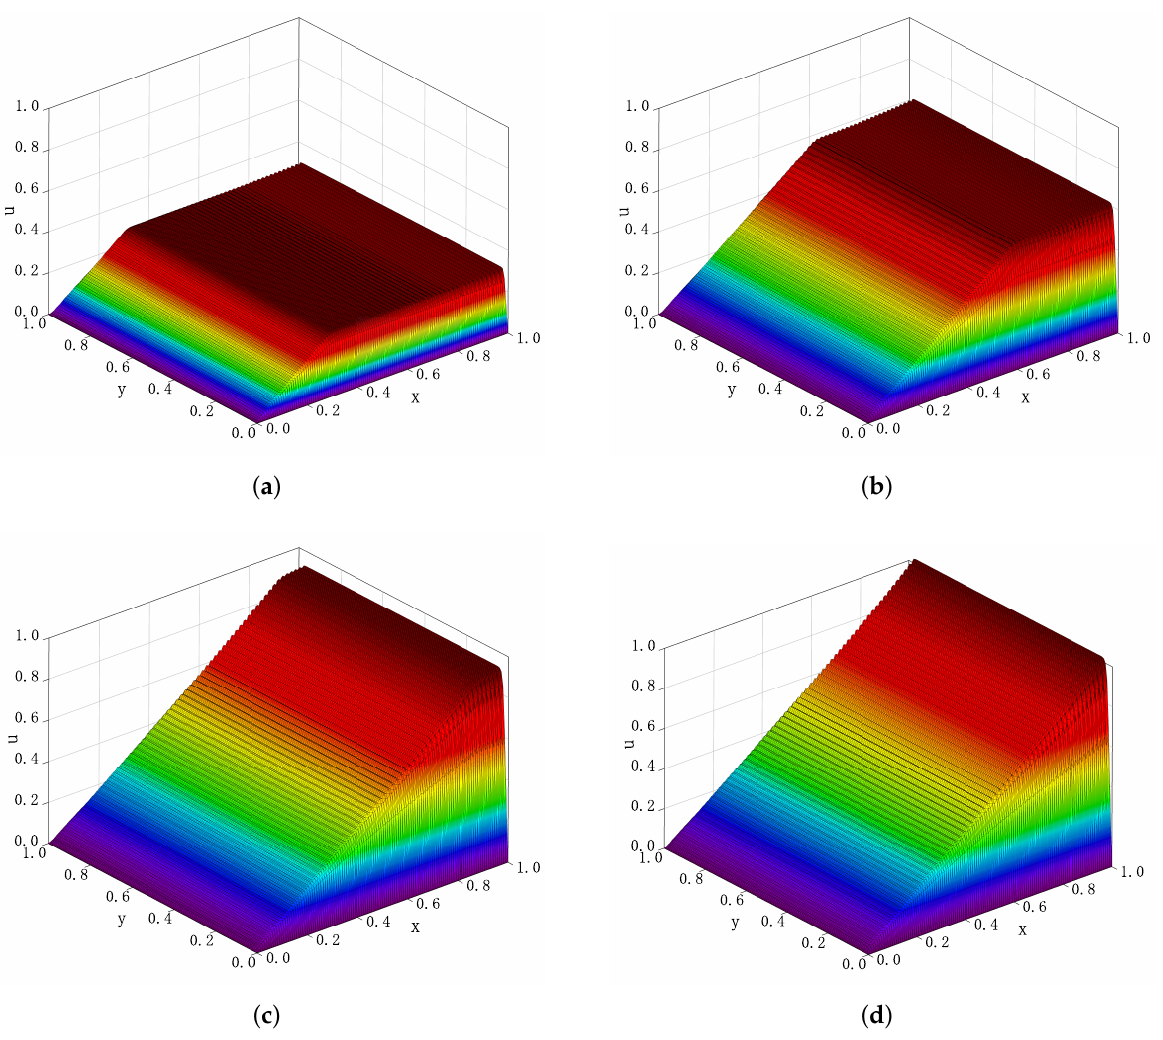
, τ = 0.001, , τ = 0.001, 120 120